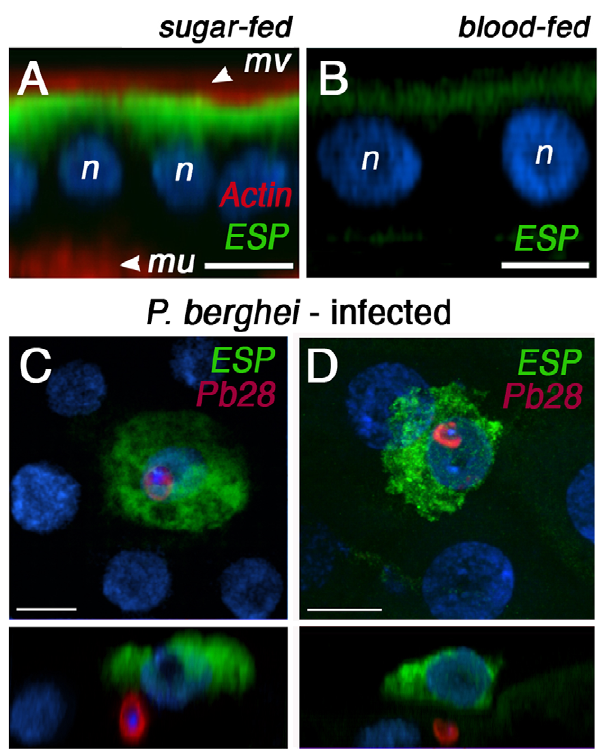
Figure 2. AgESP immunolocalization and expression in mid- guts infected with Plasmodiumberghei . AgESP protein expression in midguts from (A) sugar-fed females or (B) 24 h post-feeding (PF) on healthy mouse. Nucleus (n), microvilli (mv), Basal lamina (mu). AgESP protein (green), actin (red), and nucleus (blue). (C, D) Immunofluores- cence staining of P. berghei -infected midguts 28 h PF. AgESP protein (green), Pbs28 on the ookinete surface (red), and nucleus (blue). Top views are shown in the upper panels and the corresponding side views in the lower panels.